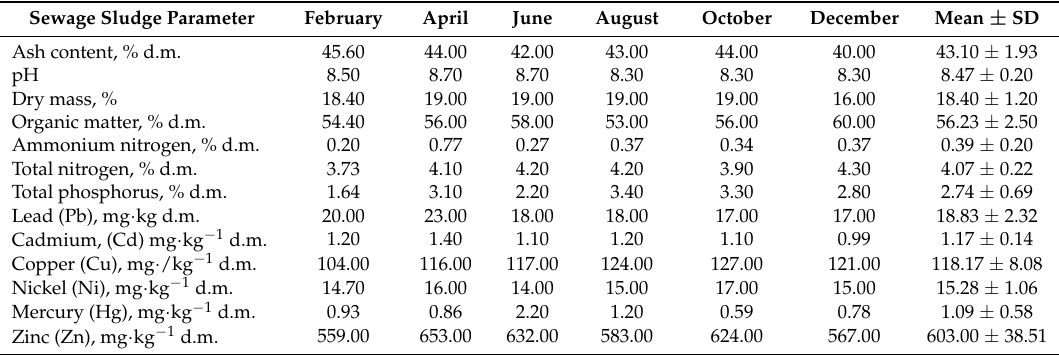
Table 1. Prosperities of sewage sludge from MWWTP in Jastrz˛ebie-Zdr ó j (results of 6 months of data gathered in 2016, mean ± standard deviation